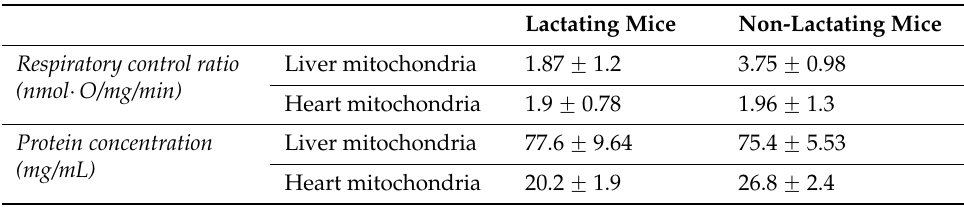
Table 1. Respiratory control ratios (State III/State IV) and protein concentrations of isolated liver and heart mitochondria from lactating and non-lactating C57BL/6NCrl mice. Data are means ˘ SEM.